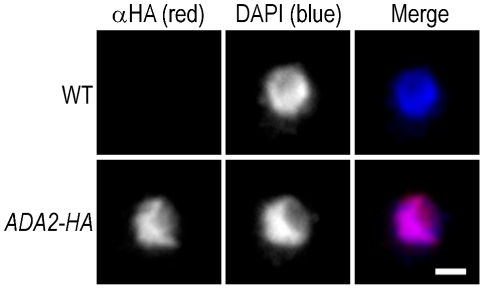
Cryptococcal Ada2 is localized to the nucleus.Wild type cells (WT) and cells modified to express HA epitope-tagged Ada2 from the native locus (ADA2-HA) were labeled with an antibody against HA (αHA, red), and counter-stained with DAPI (blue) to show the location of chromatin. All images were acquired at the same settings and are shown at the same magnification. Scale bar, 1 µm.